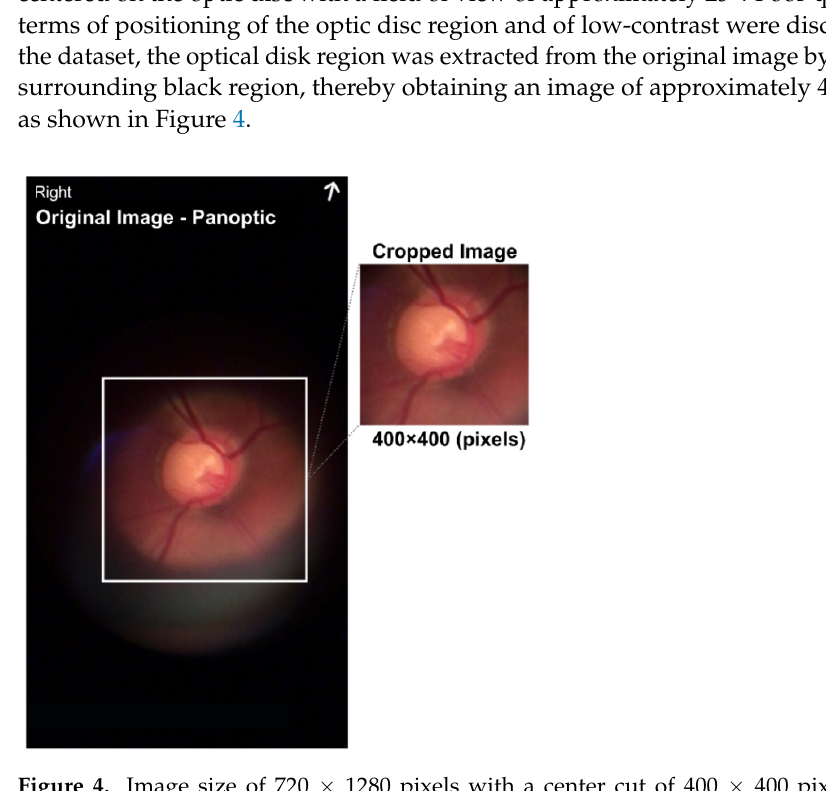
Figure 4. Image size of 720 × 1280 pixels with a center cut of 400 × 400 pixels in the region representing the optical disk.